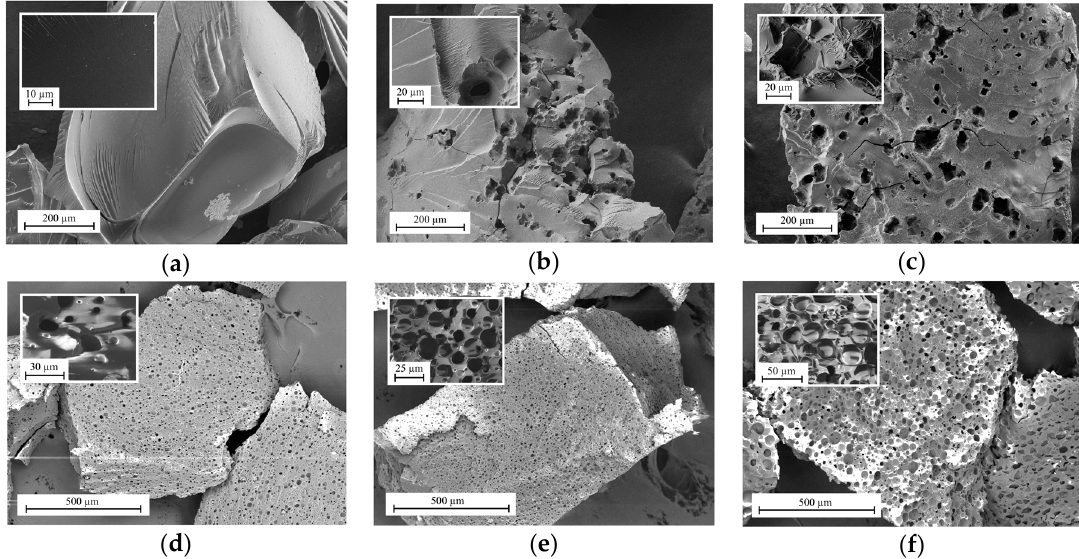
Figure 1. SEM images of RF-resins ( a ) RFR-i, ( b )RFR-10, ( c ) RFR-25, ( d ) RFR-25t, ( e ) RFR-35t, and ( f ) RFR-65t.